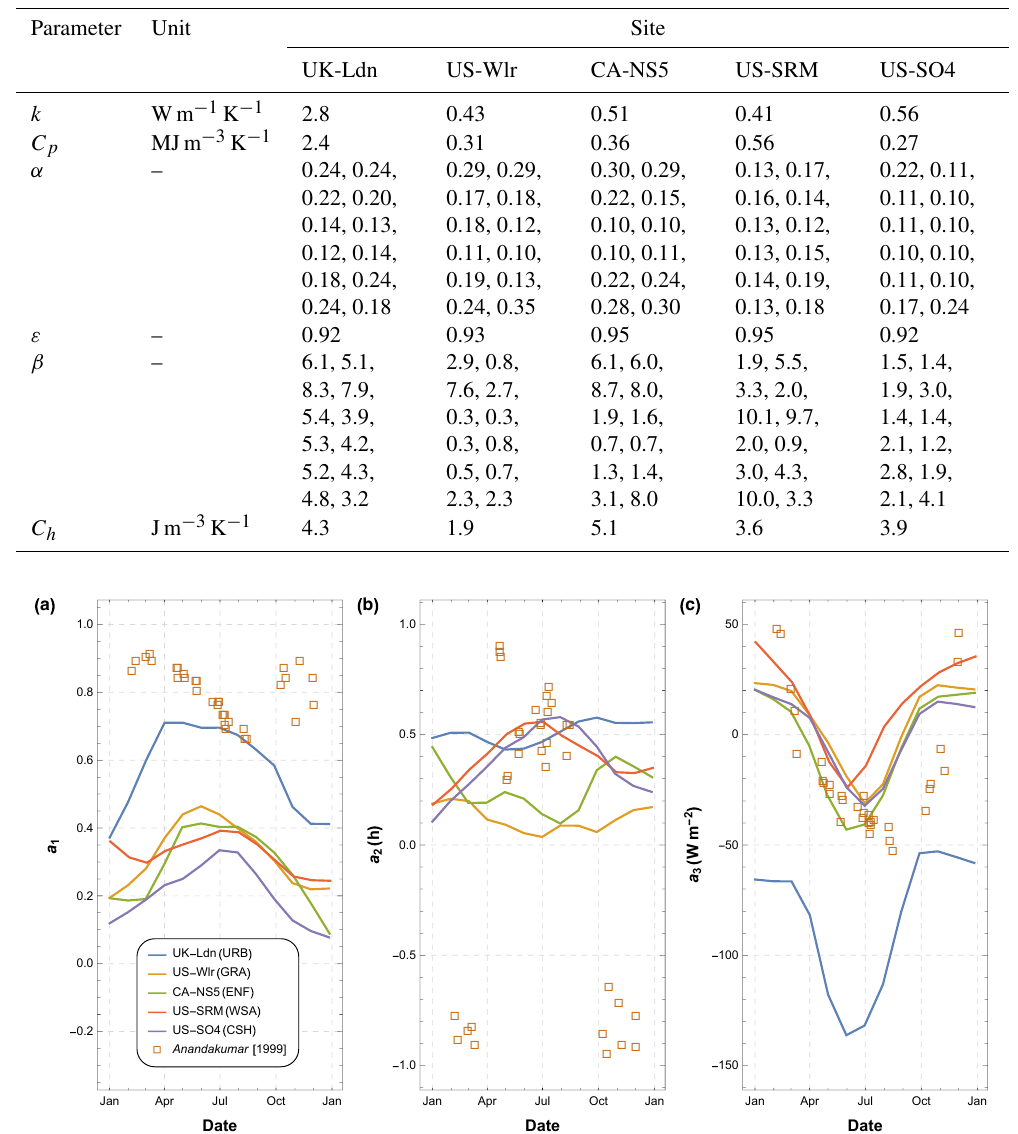
Table 3. Surface properties used in AnOHM simulation for the study sites based on calibration. The values of α and β are monthly climatol- ogy from January to December and are used when observations are not available (see Table 1 for notation definition).